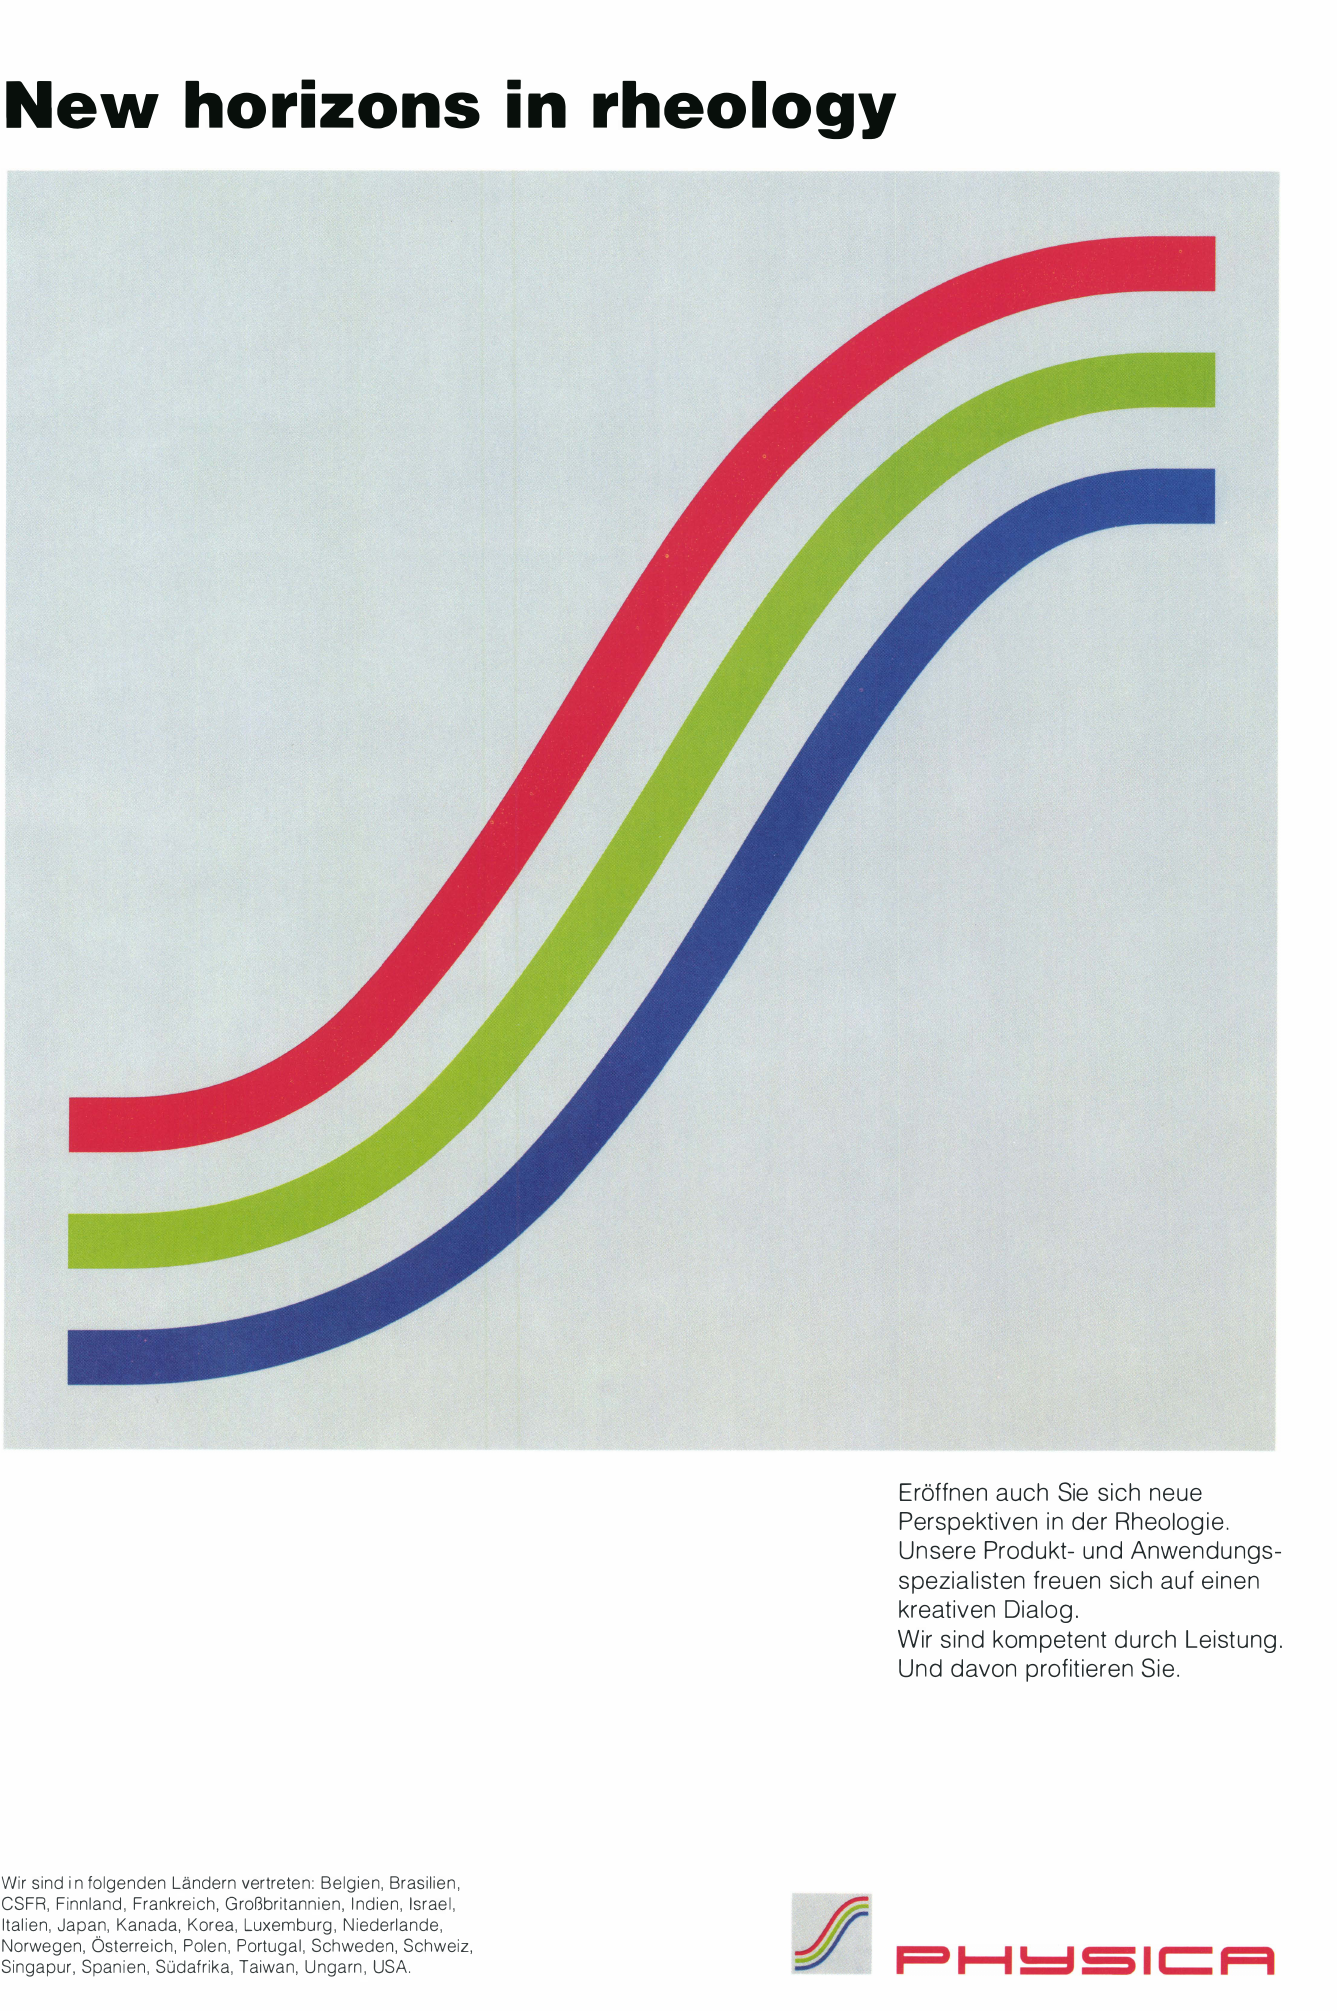
Wir sind i n folgenden Uindern vertreten: Belgien, Brasilien, CSFR, Finnland, Frankreich, GroBbritannien, lndien, Israel, ltalien, Japan, Kanada, Korea, Luxemburg, Niederlande, Norwegen, 6 sterreich, Polen, Portugal, Schweden, Schweiz, Singapur, Spanien, SOdafrika, Taiwan, Ungarn, USA